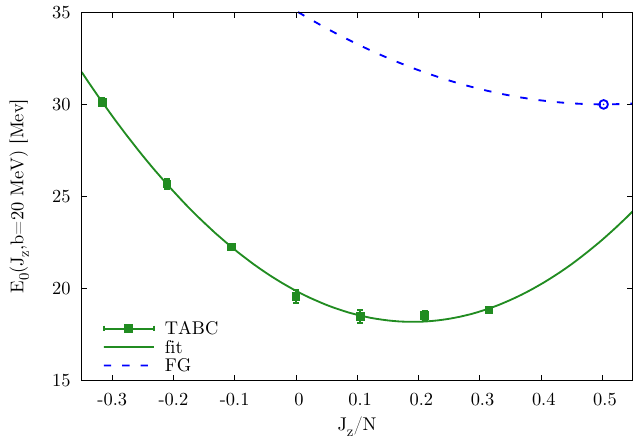
Figure 4. Same as Figure 2, but for external magnetic field b = 20MeV.